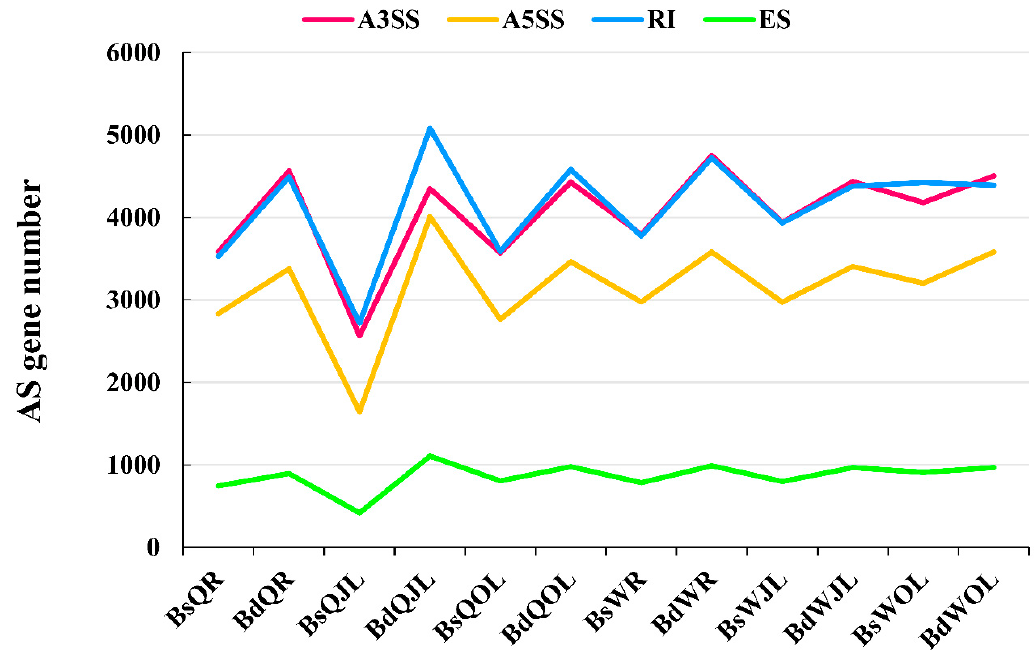
Figure 5. The number of genes of four types of alternative splicing (AS) in B. napus cultivars Qingyou10 (QY10) and Wesatr10 (W10) under boron (B) sufficient and deficient conditions. Q, QY10, QY10, Qingyou10; W, W10, Westar10; Bs, B sufficient condition; Bd, B deficient condition; R, root; JL, juvenile leaves; OL, old leaves; A3SS, alternative 3 ′ splice site; A5SS, alternative 5 ′ splice site; RI, retain intron; ES, exon skip.